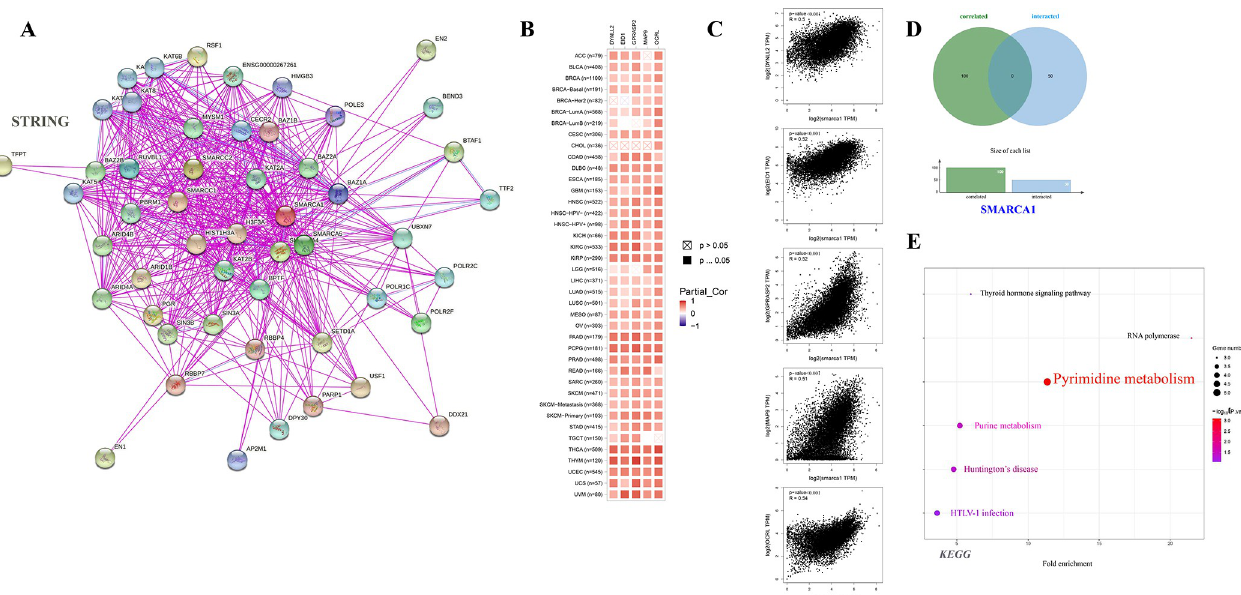
(all P < 0.001) (Fig 13C).